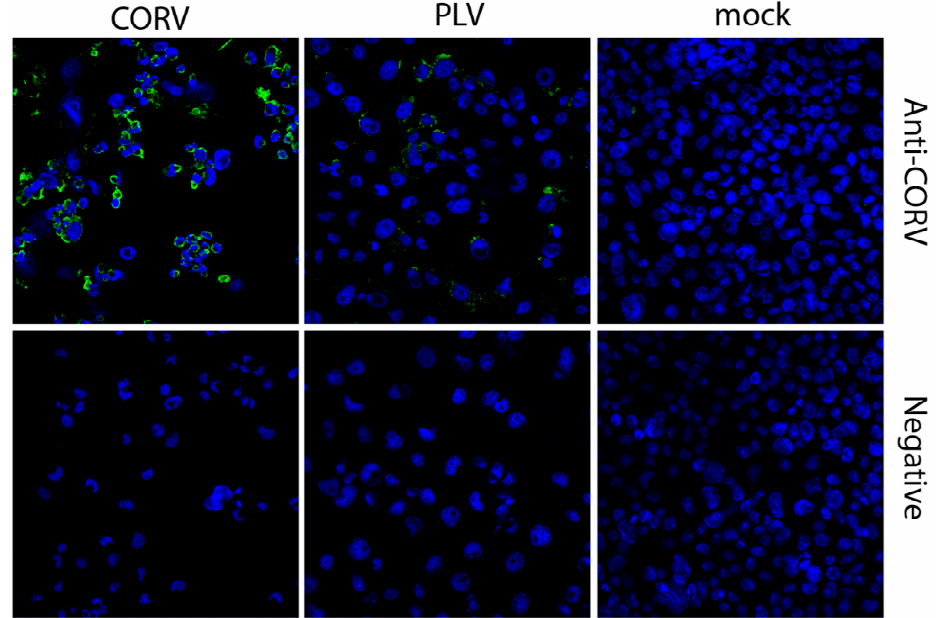
Figure 4. Serological Cross-Reactively Studies. C6/36 cells were inoculated with CORV or PLV at an MOI of 1, or mock-infected and fixed with 4% formaldehyde containing 0.1% triton X-100 after 4 days. IFA was performed by probing with rabbit sera raised against CORV CSIRO109l or naïve rabbit serum (negative) to assess cross-reactivity with PLV. Images were taken using ×40 magnification.